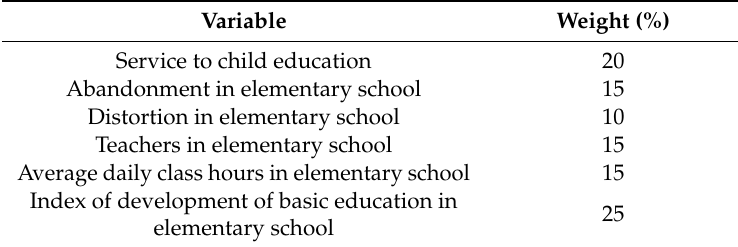
Table 2. Education Area - Weights of Variables.